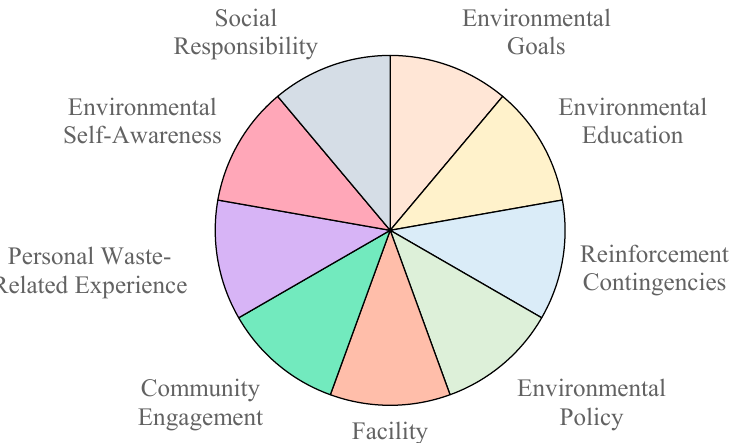
Figure 3. Main factors influencing USM’s community campus’ pro-environmental behaviour.